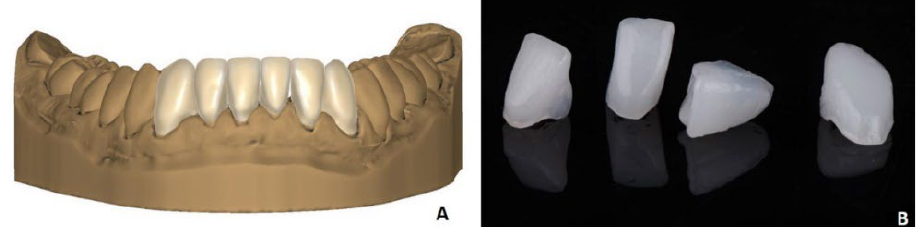
Figure 2. ( A ) Six frontal restorations designed in DentalCAD software; ( B ) additively manufactured veneers with LCM technology directly after printing.